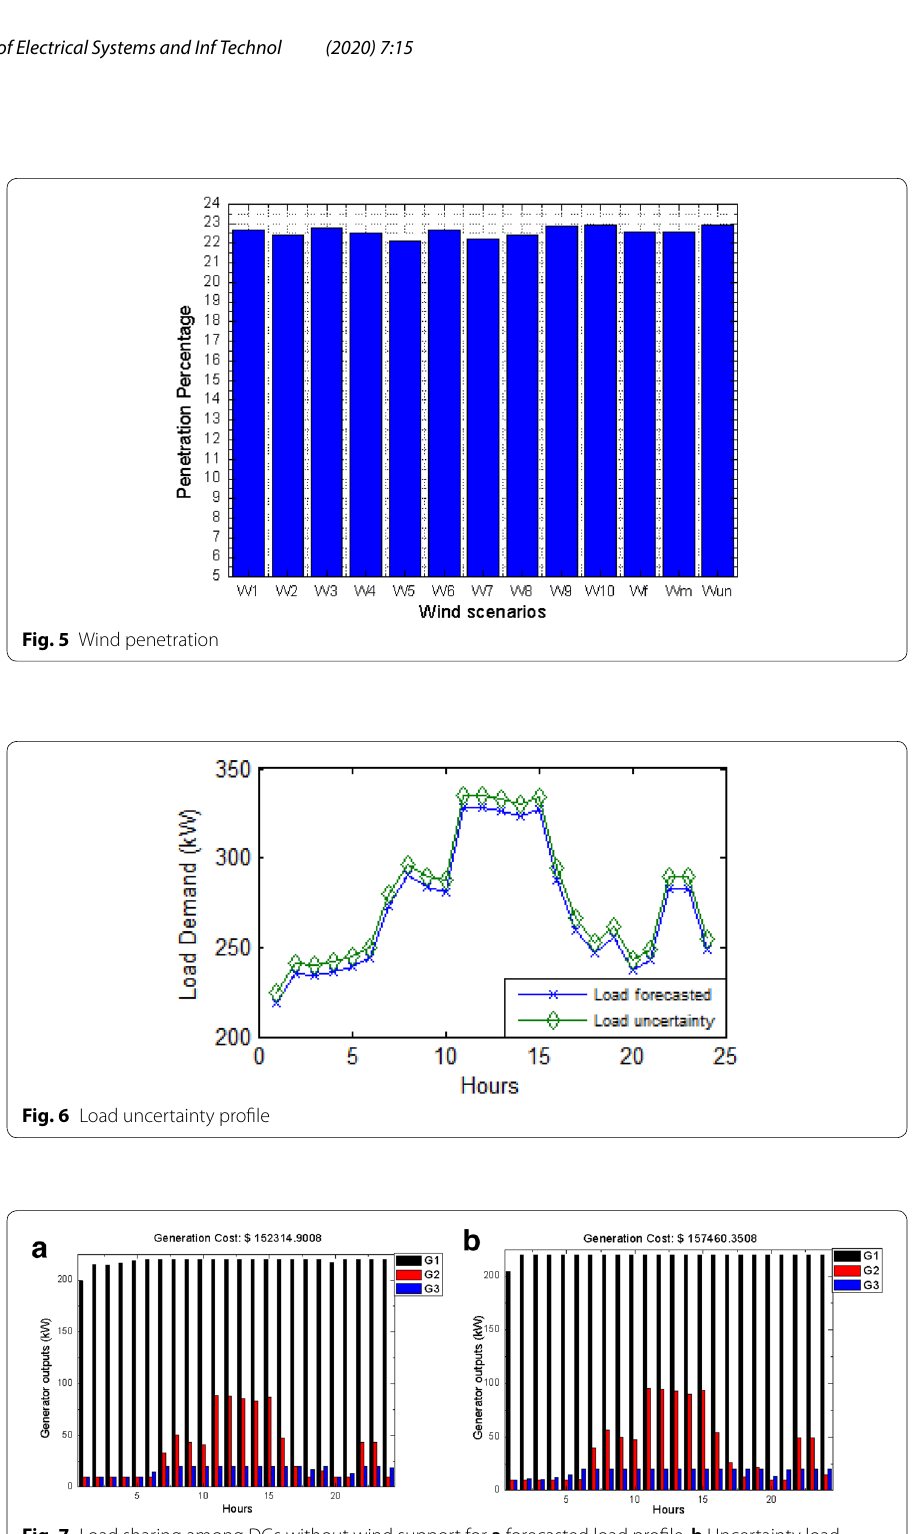
Fig. 7 Load sharing among DGs without wind support for a forecasted load profile. b Uncertainty load